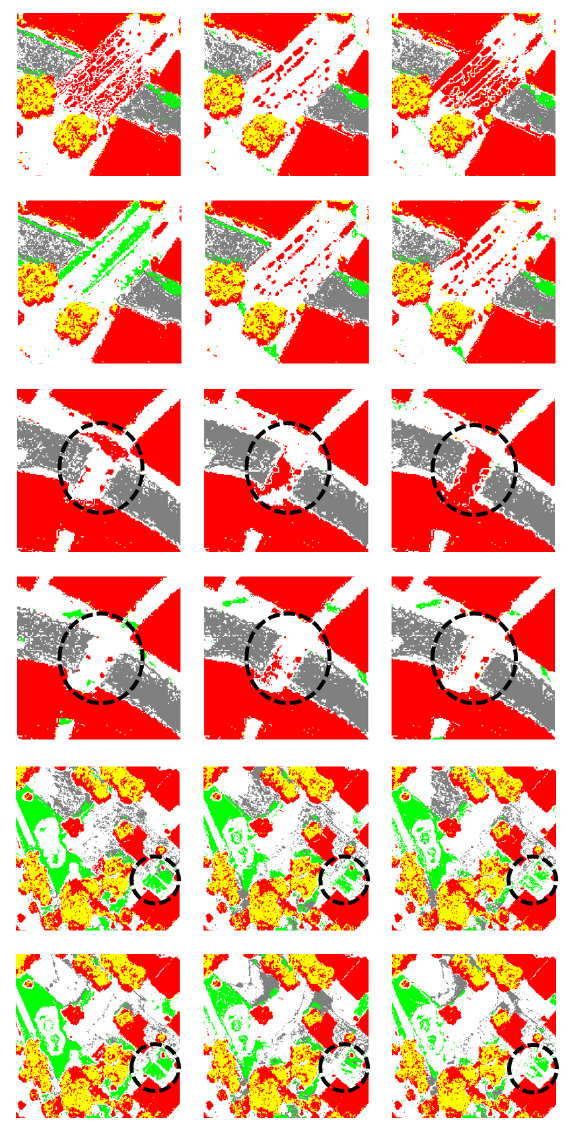
Figure 14. Detailed views of classification results for Areas I, II, III: DTM generation (rows: 1, 3, 5) using (left to right): L 1 spline (1), L 2 spline (2), Gridfit method (3); DTM generation with OSM data (rows: 2, 4, 6) using (left to right): L 1 spline (4), L 2 spline (5), Gridfit method